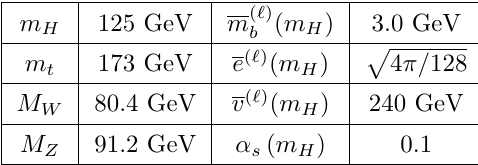
Table 1 . Input parameters employed throughout the calculation, where we have also listed